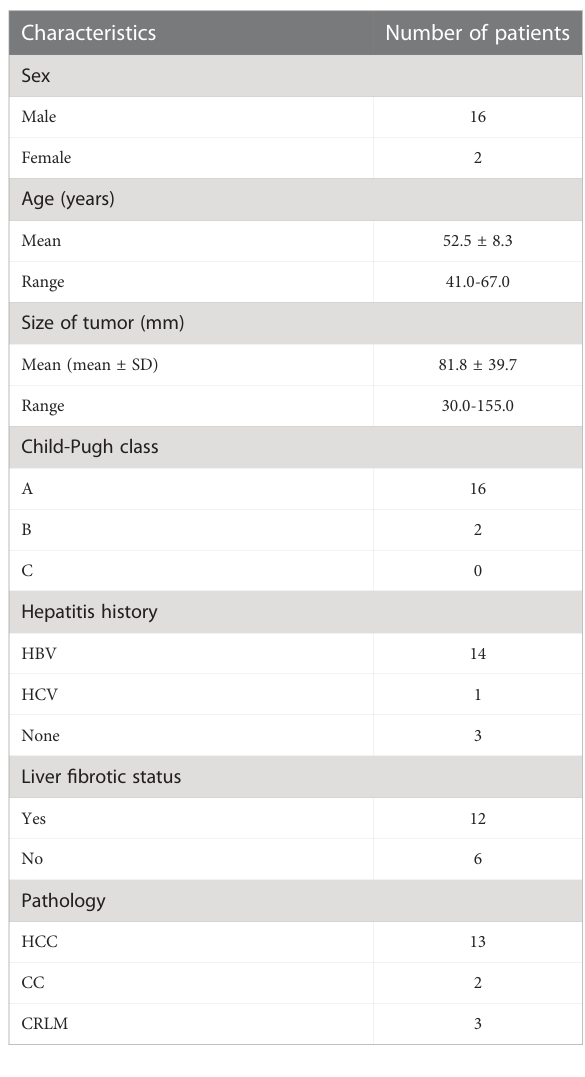
TABLE 1 Characteristics of